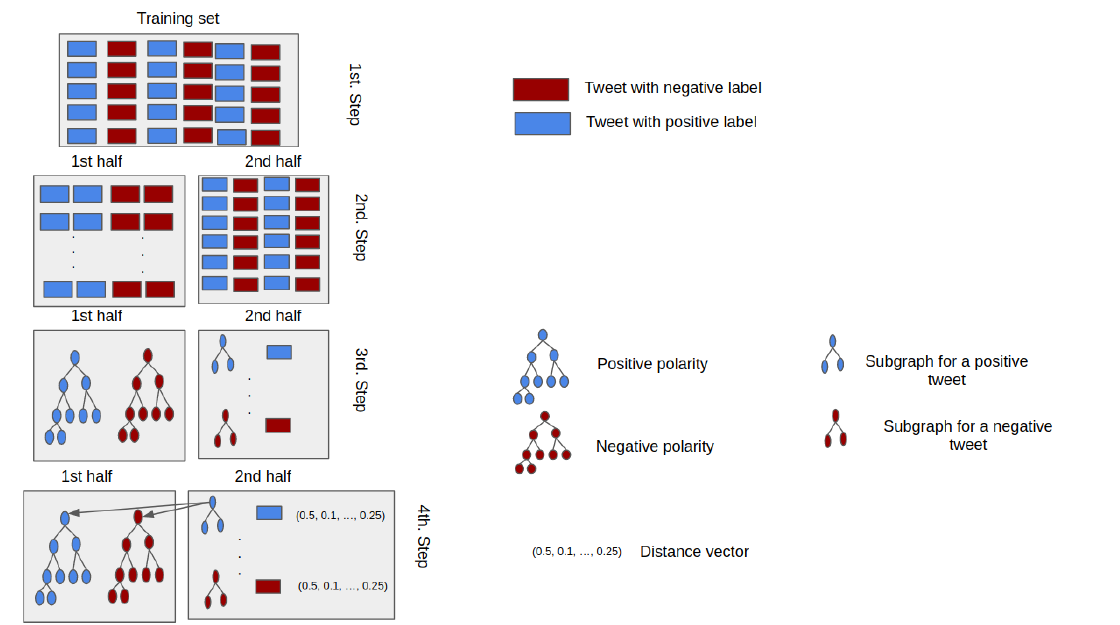
Figure 8. Transformation stages of a dataset to its vector form in the Knowledge Graph